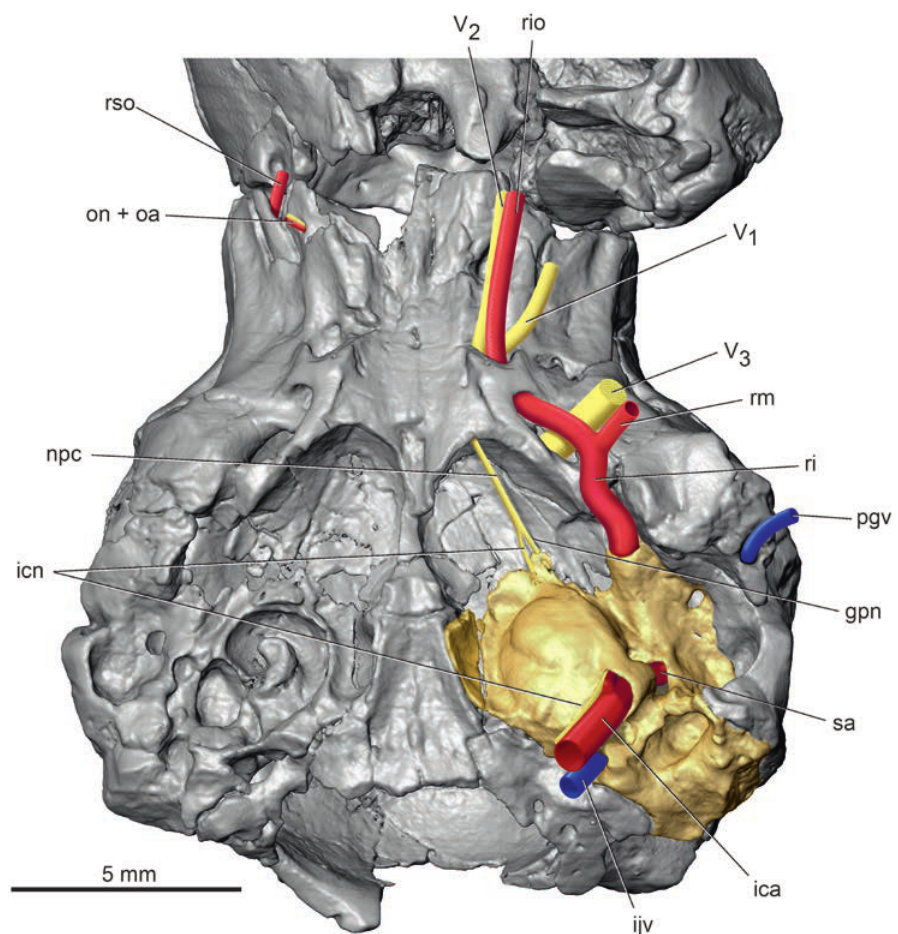
Fig. 5. Palaeoryctid mammal Eoryctes melanus Thewissen and Gingerich, 1989, UM 68074 (UM locality SC-133, Clarks Fork Basin, Wyoming, USA; early Wasatchian Land-Mammal Age, early Eocene), isosurface of cranium rendered from CT scans in ventral view, with neurovascular structures recon- structed based in part on Avizo segmentation (left petrosal in gold; arteries in red; veins in blue; nerves in yellow). The alisphenoid canal is broken on the left side in UM 68074 (see Fig. 1), but is reconstructed here to show the course of the ramus infraorbitalis. Abbreviations: gpn, greater petrosal nerve; ica, internal carotid artery; icn, internal carotid nerve; ijv, internal jugular vein; npc, nerve of pterygoid canal; on + oa, optic nerve and ophthalmic artery; pgv, postglenoid vein; ri, ramus inferior; rio, ramus infraorbitalis; rm, ramus mandibularis; rso, ramus supraorbitalis; V 1 , ophthalmic nerve, first division of trigeminal nerve; V 2 , maxillary nerve, second division of trigeminal nerve; V 3 , mandibular nerve, third division of trigeminal